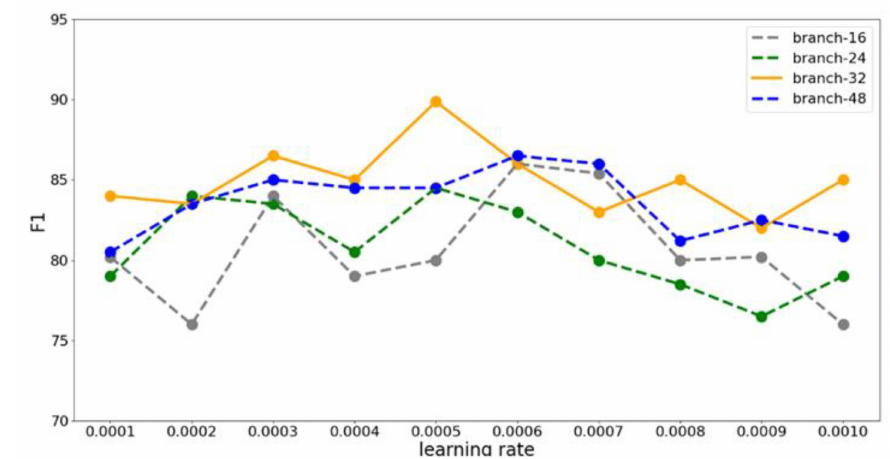
Figure 14. The effect of different learning rates on F1